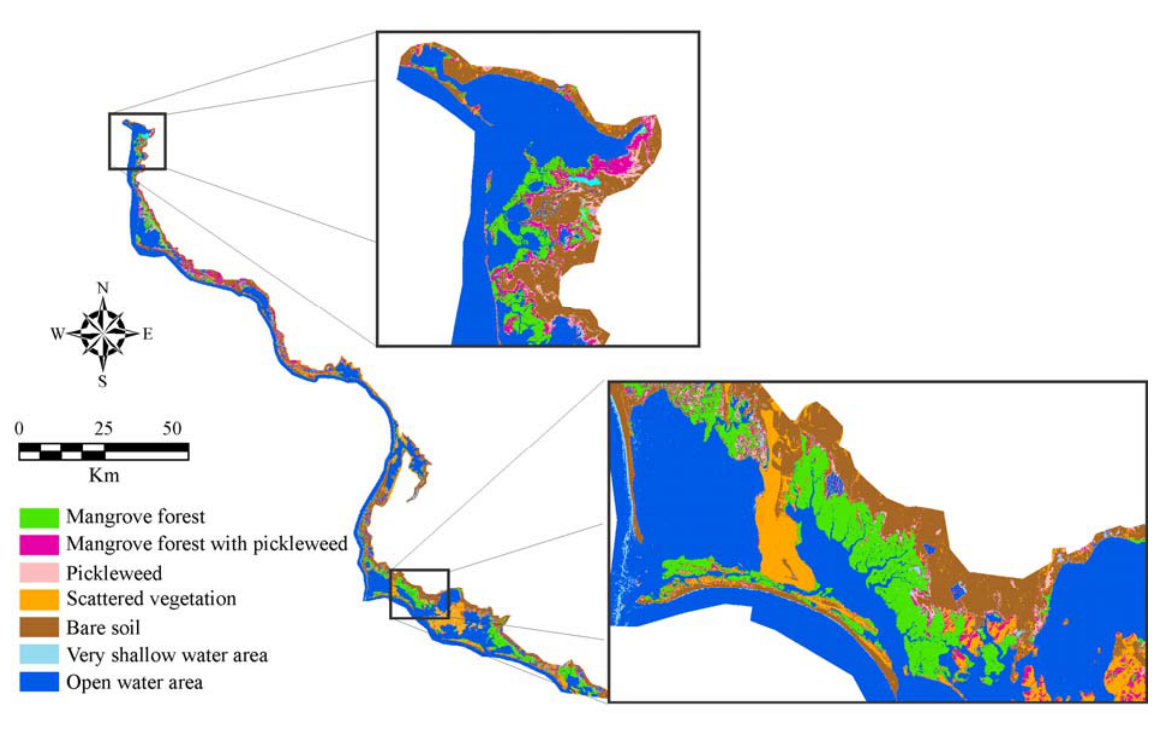
Figure 4. Land cover map based on supervised classification using the maximum likelihood method and the maximum probability classification